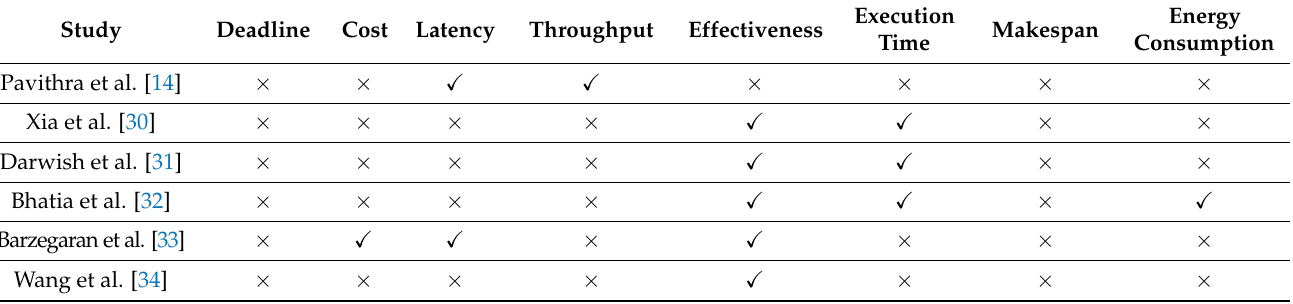
Table 7. Analysis of articles in terms of evaluation parameters in smart grid